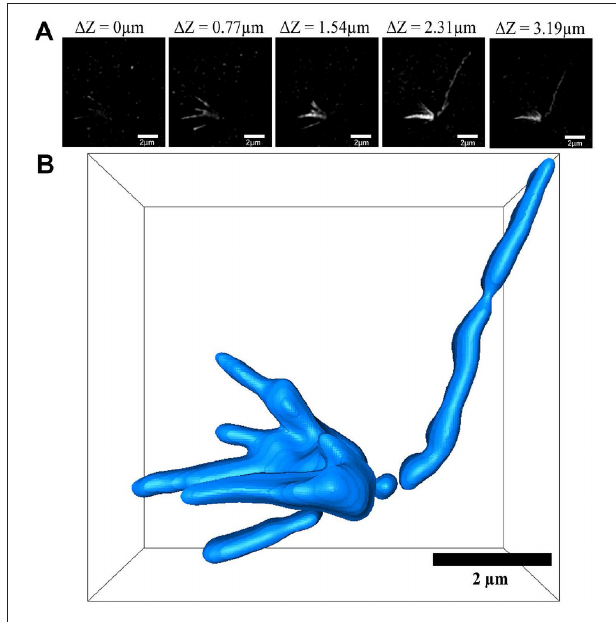
FIGURE 4 | Three-dimensional reconstruction of α -tubulin. (A) SIM images views at different z-levels. (B) Three-dimensional reconstruction using Avizo software. Scale bar, 2 µ m (A,B) . All bars were physical scales before correction with expansion factor. The expansion factor is